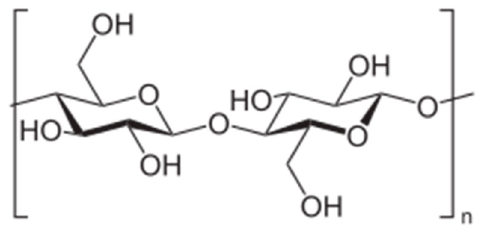
Figure 11. Chemical structure of cellulose.